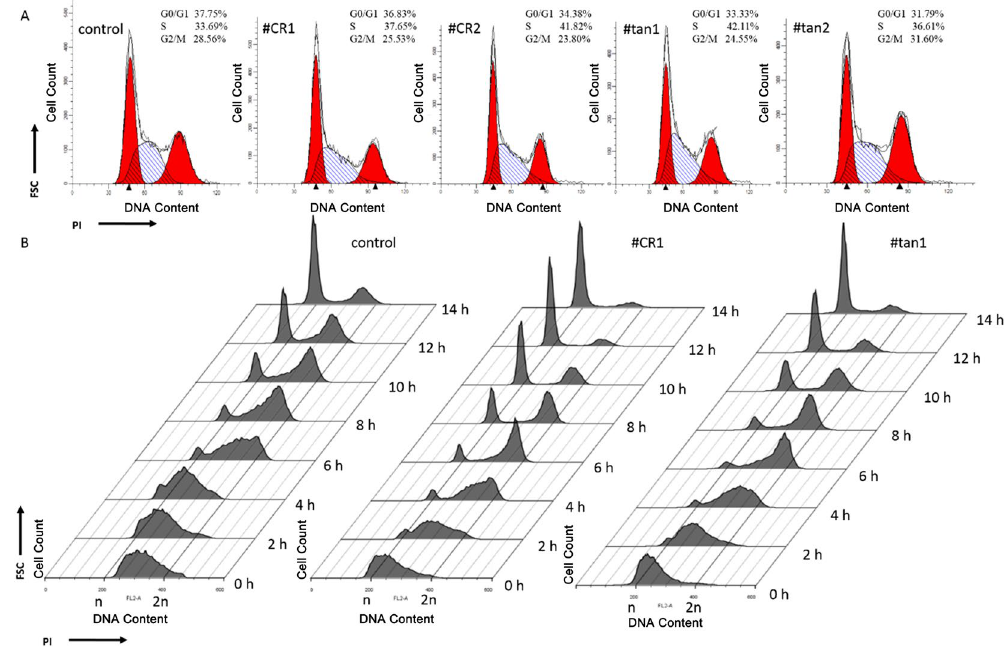
Figure 3. APA switching of CCND1 accelerates cell cycle progression. ( A ) Cell cycle analysis by DNA content. Synchronized cells were stained with propidium iodide after 6 hours in culture, and percentages of the cell population in the different phases of the cell cycle were determined by flow cytometry. ( B ) Dynamic cell cycle profiles. Cells were arrested in the G1/S phase with a double thymidine block and were released at several time points. Cell cycle profiles were obtained by flow cytometry after propidium iodide (PI)